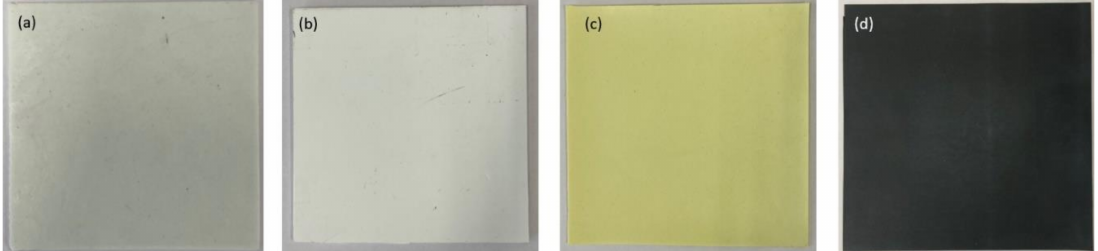
Figure 3. Comparing appearances of shielding sheets manufactured using the same process: ( a ) pow- dered oyster shell (1200 ◦ C), ( b ) barium sulfate, ( c ) bismuth oxide, and ( d )